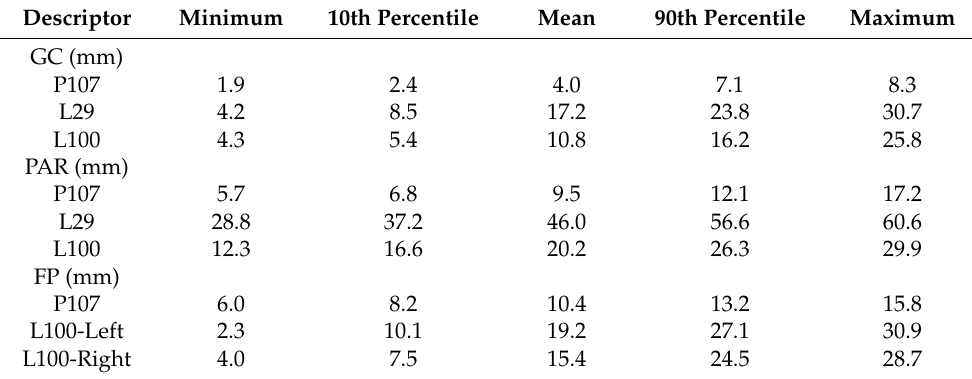
Table 7. Descriptive statistics of the depths of the gland cistern (GC), parenchyma (PAR) and mammary fat pad (FP) in late-pregnancy (P107), early lactation (L29) and weaning (L100), irrespective of treatment